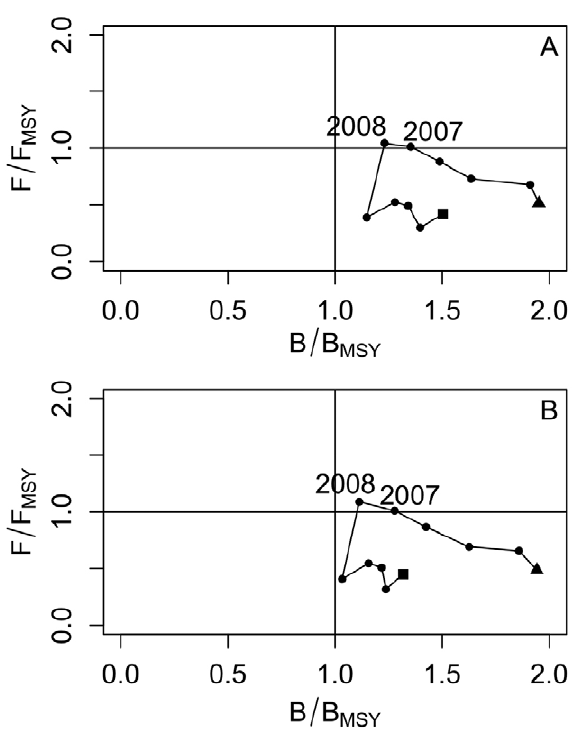
Fig. 8. – Development of the D. gigas fishery from 2003 to 2012. A, based on the PS model; B, based on the Pf-EDSP model. Triangle represents the biomass status of the first year (2003) of study; square represents the biomass status of the last year